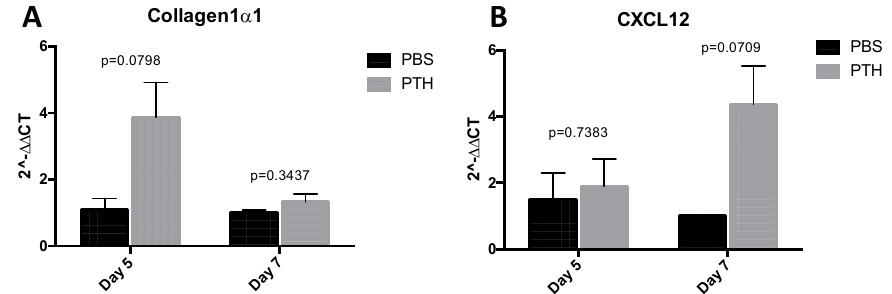
Figure 4. Assessment of osteoblast related gene expression in the front legs after PTH treatment. Mice were treated with 80 μg/kg PTH ( n = 4–5) or PBS control ( n = 3) for 5 days and culled on day 5 and day 7. RNA was extracted from whole front legs and qPCR for detection of the osteoblast related molecules Col1 α 1 and CXCL12 was performed. All data normalized to GAPDH. Data are presented as the mean ± SEM. Statistical analysis by unpaired students t -test, p values are indicated in the